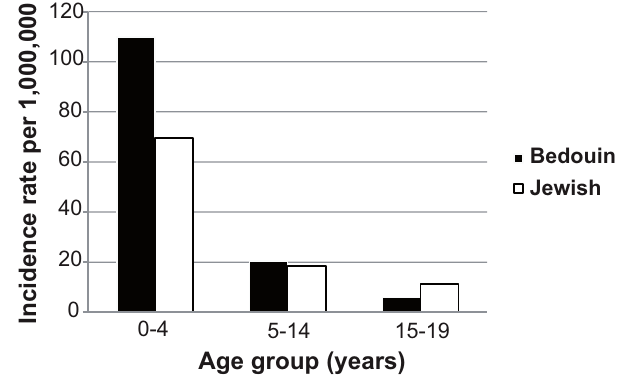
Figure 1. Y axis; age adjusted annual chronic kidney disease (CKD) incidence rate (per million). X axis: age groups (years). Black bars: children of Bedouin origin. White bars: children of Jewish origin. No p values for comparison are provided since the total population (and not a sample) is